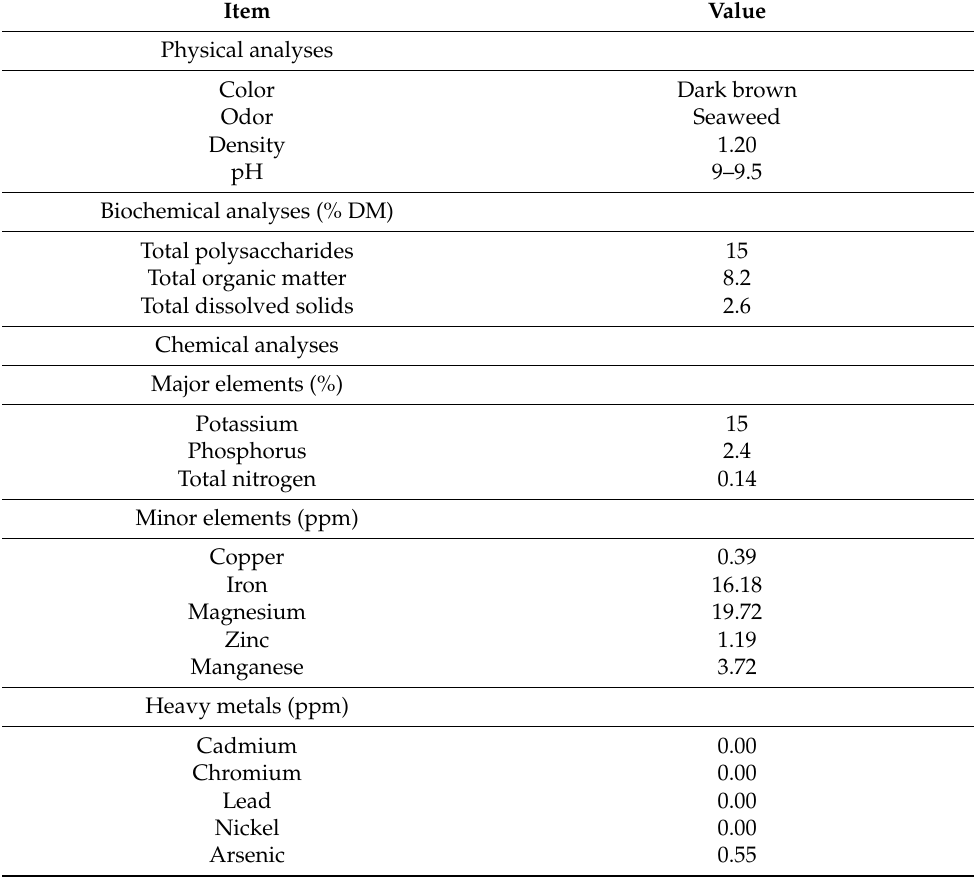
Table 1. Physical, chemical, and biochemical analyses of TAM.